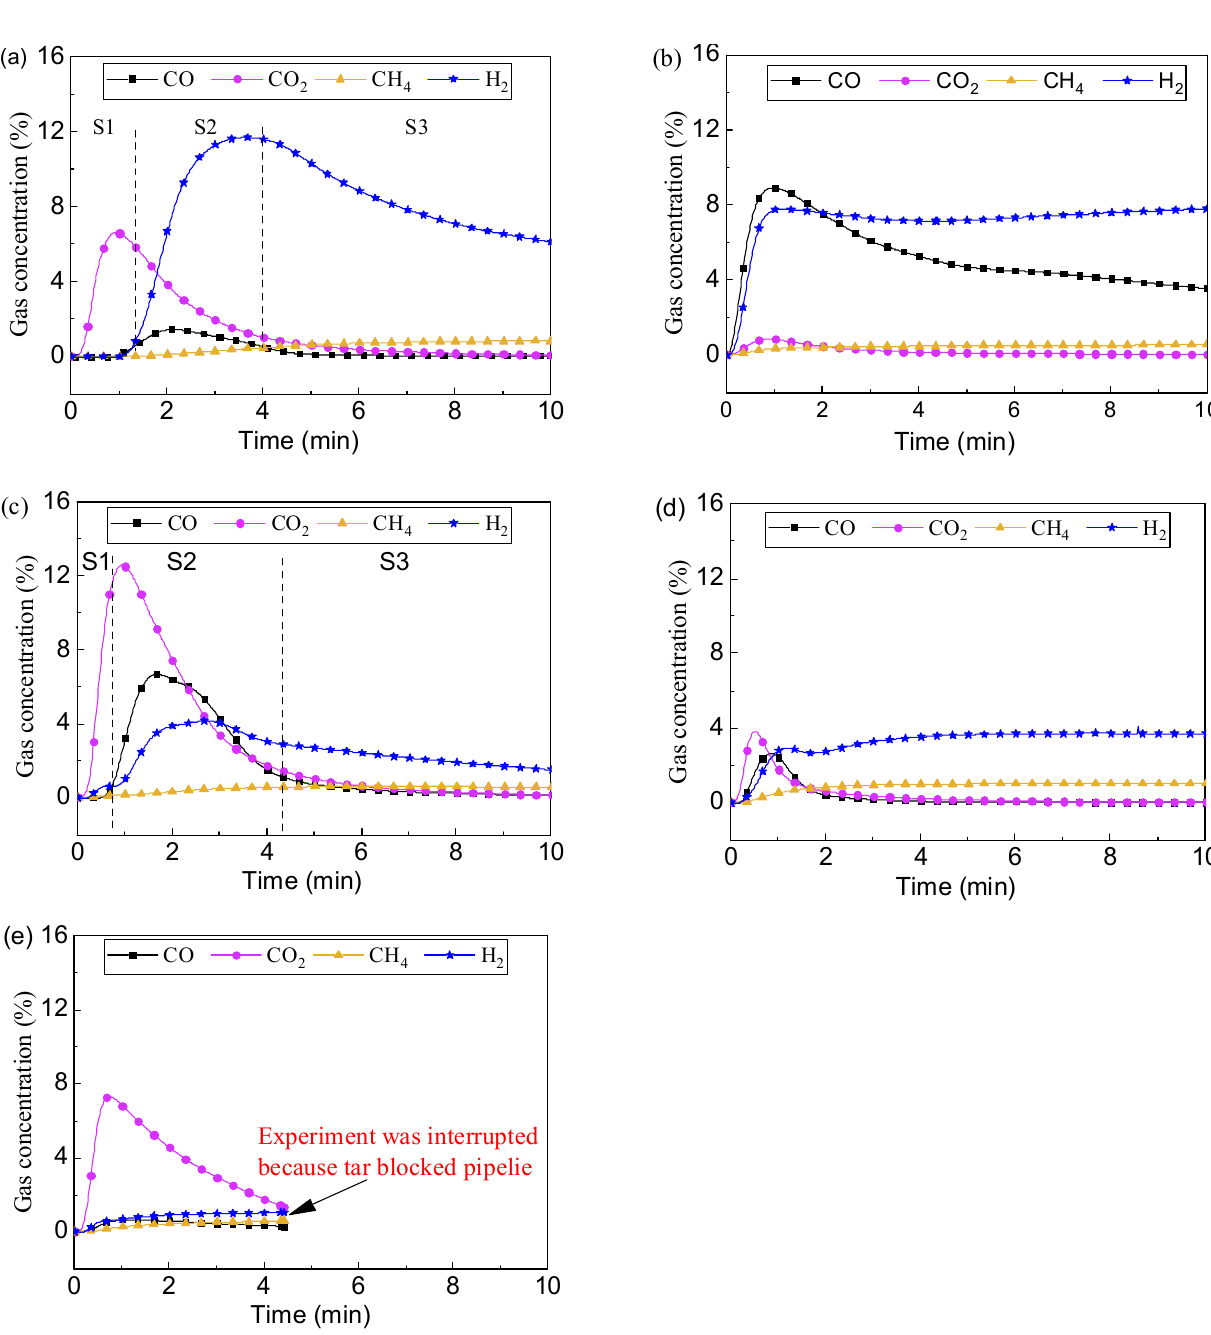
Figure 4. Gas concentration versus reaction time at 900 °C with typical oxygen carrier: ( a ) LaNi, ( b ) LaFe, ( c ) LaCo, ( d ) LaMn and ( e ) LaCu.